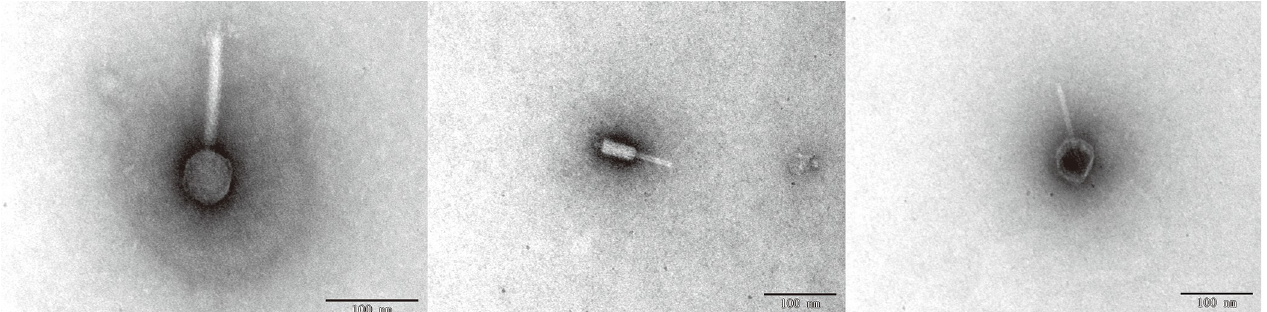
Fig 2. Morphology of the phage vB_VpS_PG28 under transmission electron microscopy.